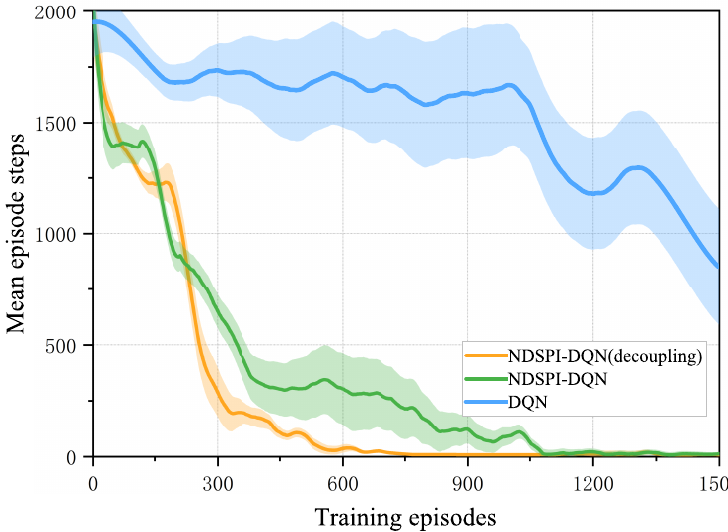
Figure 5. Mean episode steps versus training episodes for different algorithms in scenario